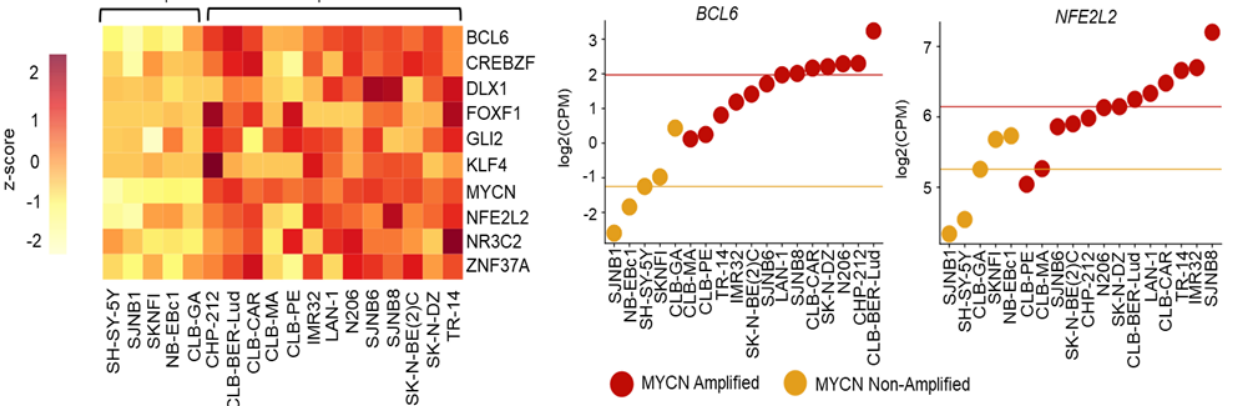
Figure 2. An intratumor meta-analysis of gene expression programs in MYCN -amplified and non- amplified neuroblastoma cell lines. A clear trend of upregulation of MYCN and additional cancer- related TFs was observed in MYCN -amplified samples. ( Left ) A heatmap depicts the expression of each TF-encoding gene examined, across diverse neuroblastoma cell lines (log 2 CPM; Counts per Million). ( Middle ) BCL6 demonstrates a pattern of elevated expression in MYCN -amplified compared to non-amplified neuroblastoma cell lines. ( Right ) same as in Middle for NFE2L2 .